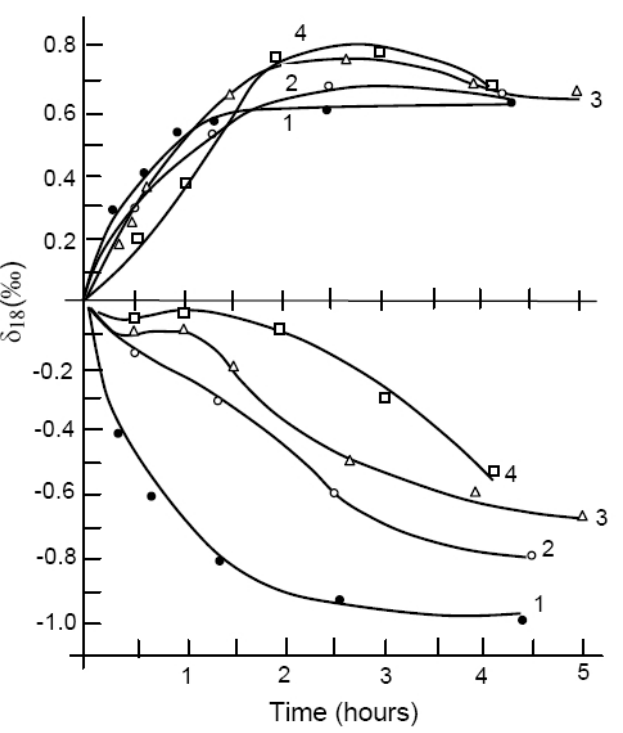
Fig. 9 Isotope separation of oxygen as a result of the temperature gradient across the membrane with different rates of hydraulic flow through the membrane from the hot cell. δ changes in both cells over time: membrane-75 μ , temperatures in hot and cold cells 18 are 90 and 40 ◦ C, respectively. Initially, water in both cells is normal water. Initial water quantity in the hot and cold cells are 80 and 120 ml, respectively. δ cells relates to normal water. Curve 1-no pressure, curve 2-pressure 4 atm, flow 3.6 ml h − 1 . curve 3-pressure 7 atm, flow 5.1 ml h − 1 , curve 4-pressure 15 atm, flow 8.0 ml h − 1 . Upper curves -cold cell, lower curves -hot